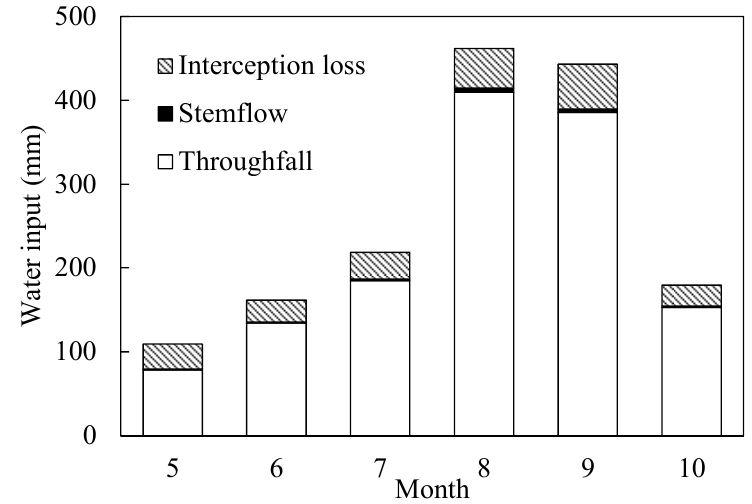
Figure 3. Monthly input of water via throughfall, stemflow and interception loss.